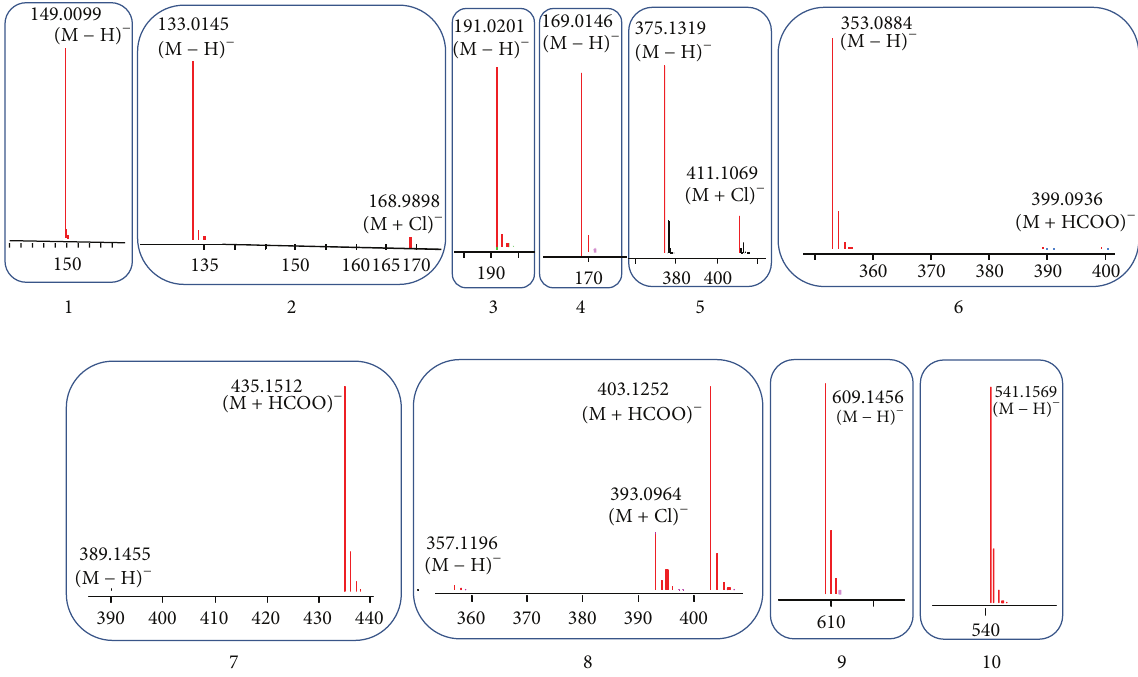
Figure 2: Accurate mass spectra (mass-to-charge, 𝑚/𝑧 ), in ESI negative mode, of phytochemical peaks identified in C. mas fruit by Agilent TOF detector. (1) Numbers 1–10 represent peaks to be characterized, that is, tartaric acid ( 1 ), malic aicd ( 2 ), citric acid ( 3 ), gallic acid ( 4 ), chlorogenic acid ( 6 ), a flavonoid glycoside rutin ( 9 ), and four iridoids, loganic acid ( 5 ), loganin ( 7 ), sweroside ( 8 ), and cornuside ( 10 ). (2) Accurate mass-to-charge ( 𝑚/𝑧 ) is labeled on the top of each